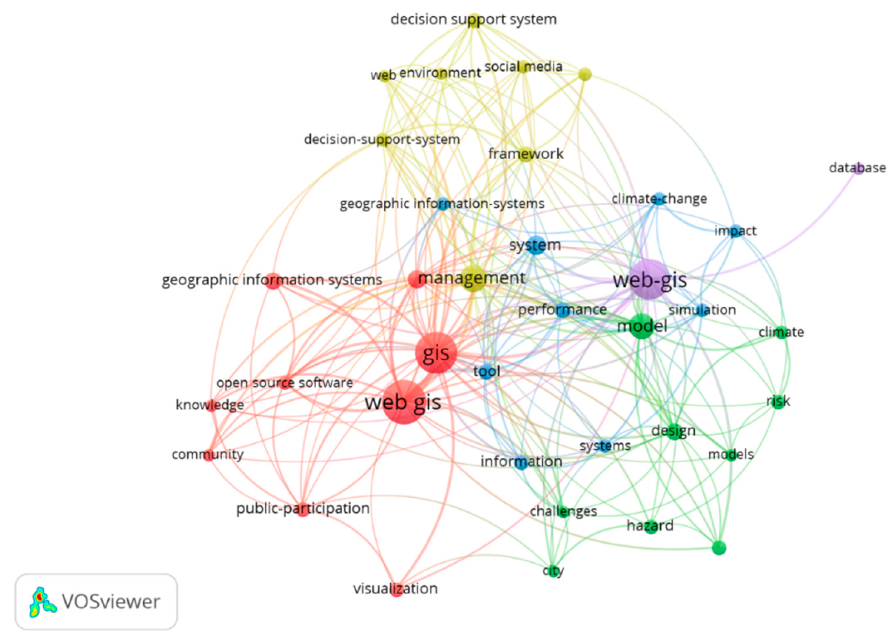
Figure 5. The network of co-occurrences of keywords related with web GIS in WoS database.